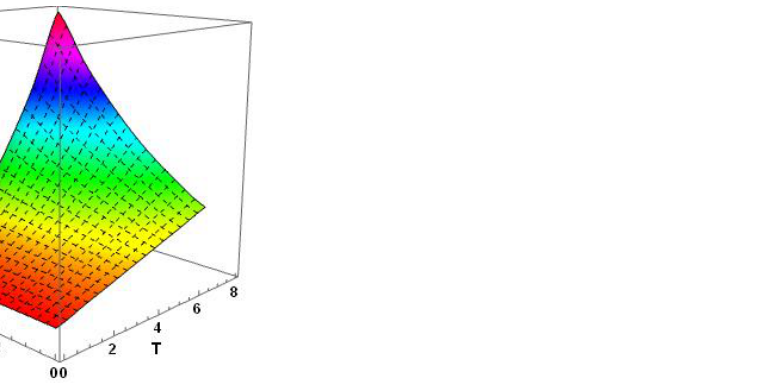
Figure 1. The impact of fractional order ( υ ) on the condition P given by (12) is represented graphically. Based on the P value given by (12) and the conditions A 1 and A 2 , the graph shown above describes the behavior of the solution of problem (29) for different values of υ ∈ ( 0,1 ) . It is noted that as T increases, the value of P increases as well and, with an increase in time, the condition P increases gradually for all values of υ ∈ ( 0,1 ) , and the P is clearly less than 1, satisfying the condition obtained in Theorem 4. An important observation to be made is that when order ( υ ) is small, the value of P decreases with increasing time. As the order ( υ ) increases, this trend changes with the value of P increasing with time. The figure describes the behavior of the